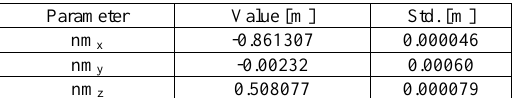
Table 4. Angular differences between camera and INS/GPS